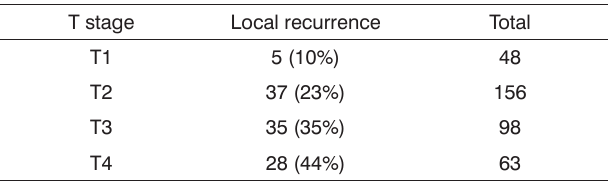
Table 3. Local recurrence per T stage ( p = 0.0002).